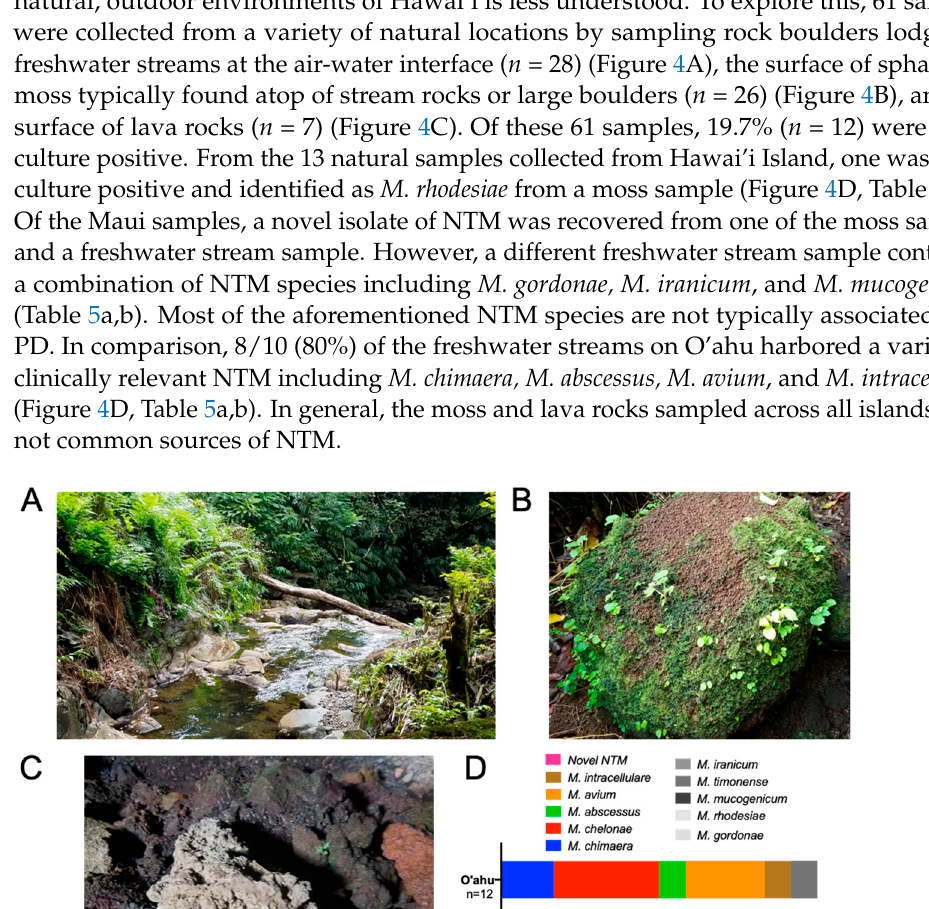
and moss from O’ahu, Maui, and Hawai’i Table 5. ( a ) Types of natural sites sampled and the proportion that were NTM culture positive; ( b ) Species of NTM identified from culture positive freshwater streams and moss.